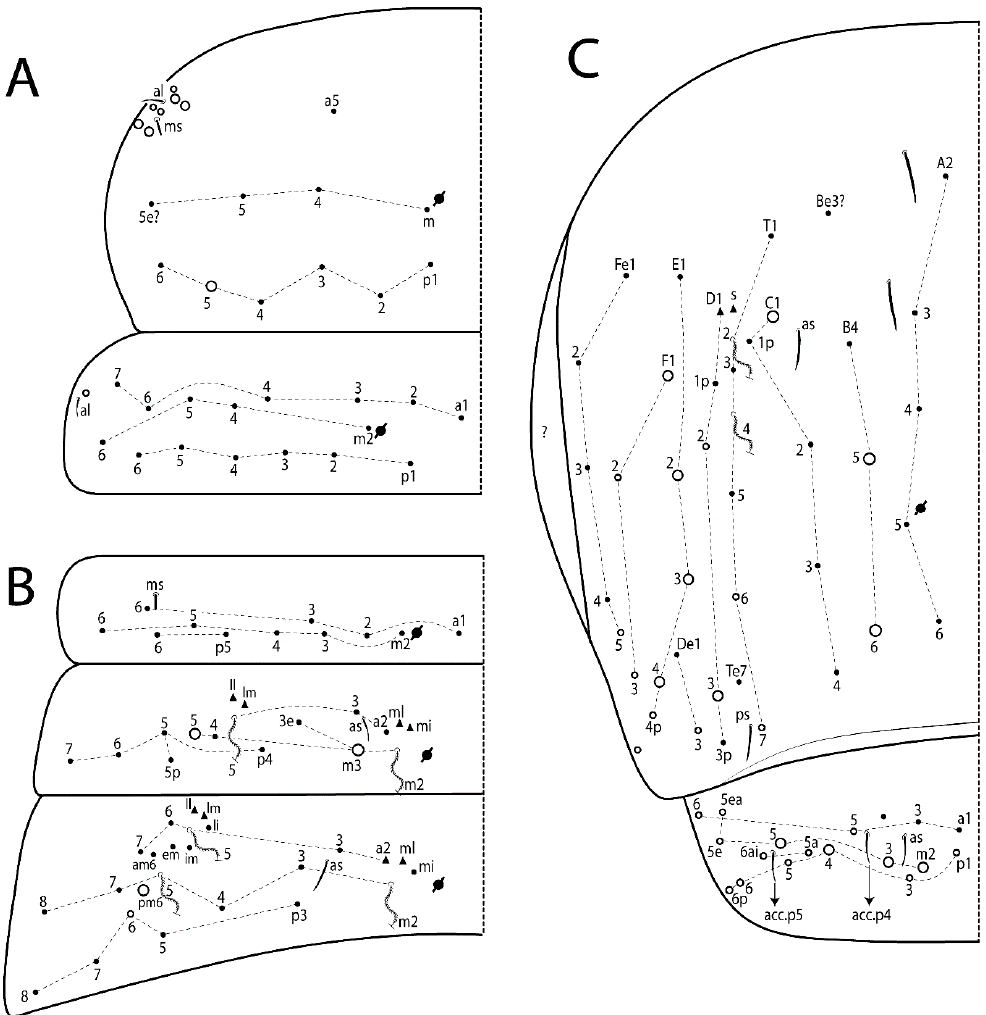
Figure 35. Pseudosinella unimacrochaetosa sp. nov.: dorsal chaetotaxy. ( A ) Th II–III; ( B ) Abd I–III; ( C ) Abd IV–V.